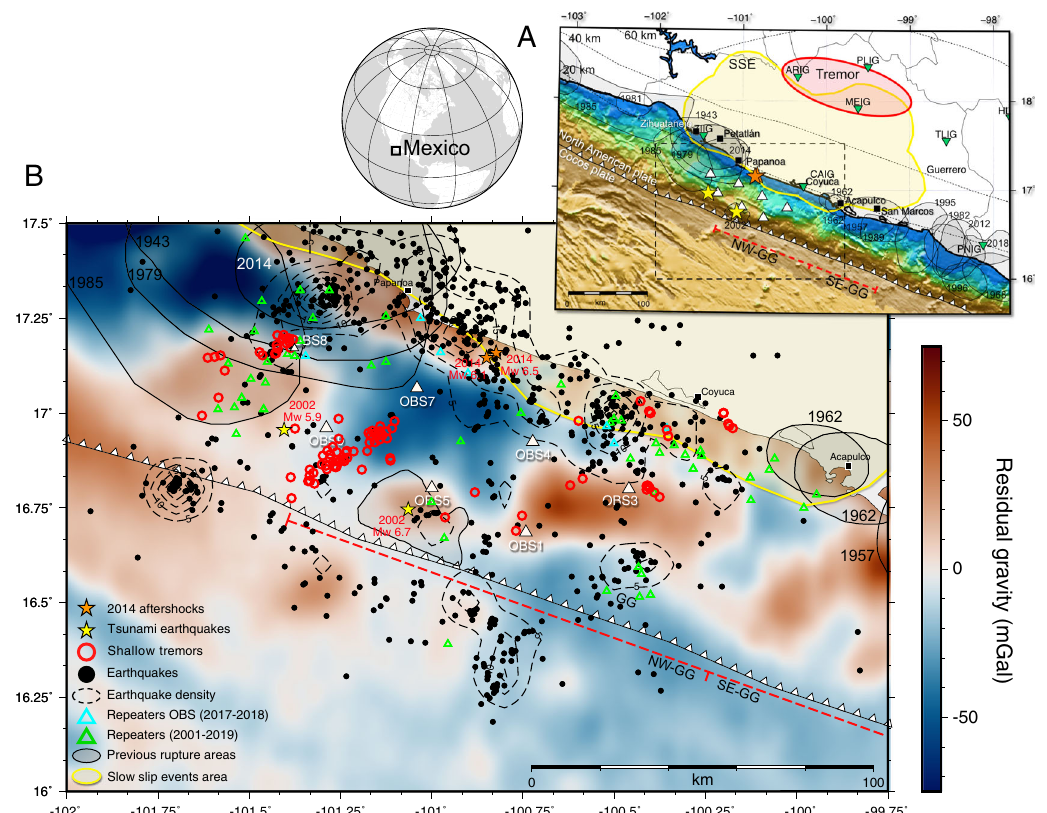
Fig. 1 Guerrero subduction zone. A White triangles and inverted green triangles show the location of ocean bottom seismometers (OBSs) and land stations, respectively. Grey, yellow and red areas are past earthquake rupture zones 10,58 , SSEs and tremors areas, respectively. Red dashed line is the Guerrero seismic gap, divided into north-west (NW-GG) and south-east (SE-GG) segments. Black dotted lines are contours for the depth of the top of the subducting slab 59 . Black squares are major population centres along the Paci fi c coast of Mexico. The black dashed square is the area shown in B . B Residual gravity at the NW-GG. Yellow and orange stars indicate epicentres of the 2002 tsunami earthquakes and aftershocks of the 2014 earthquake, respectively. Red circles, green triangles, cyan triangles and black circles are locations of STs, repeaters (2001 – 2019), OBS repeaters (2017 – 2018) and regular earthquakes, respectively. Black dashed lines are contour lines for earthquake